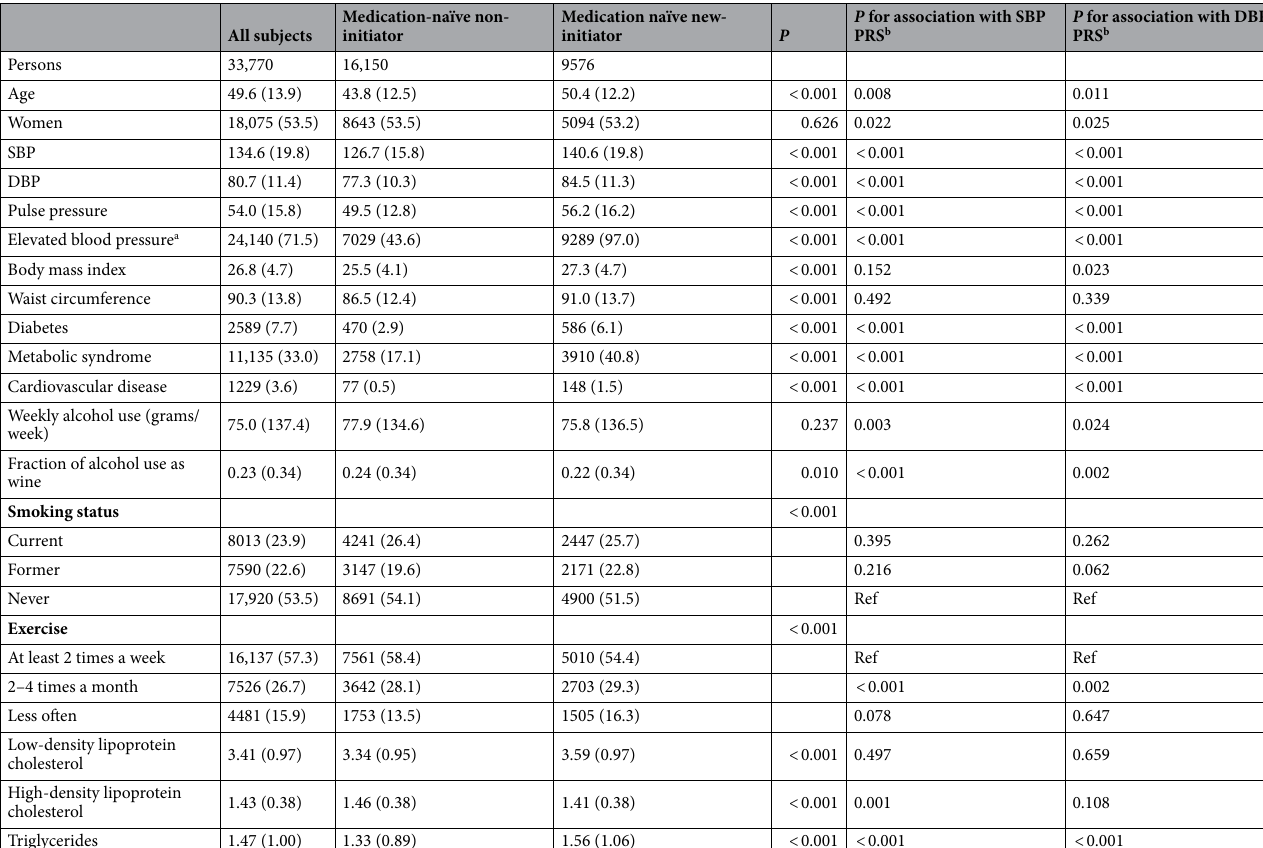
Table 1. Baseline demographics. Data are as mean (SD) or n (%). HTA, arterial hypertension; SBP, systolic blood pressure; DBP, diastolic blood pressure; PRS, polygenic risk score; Ref, reference group. a Either